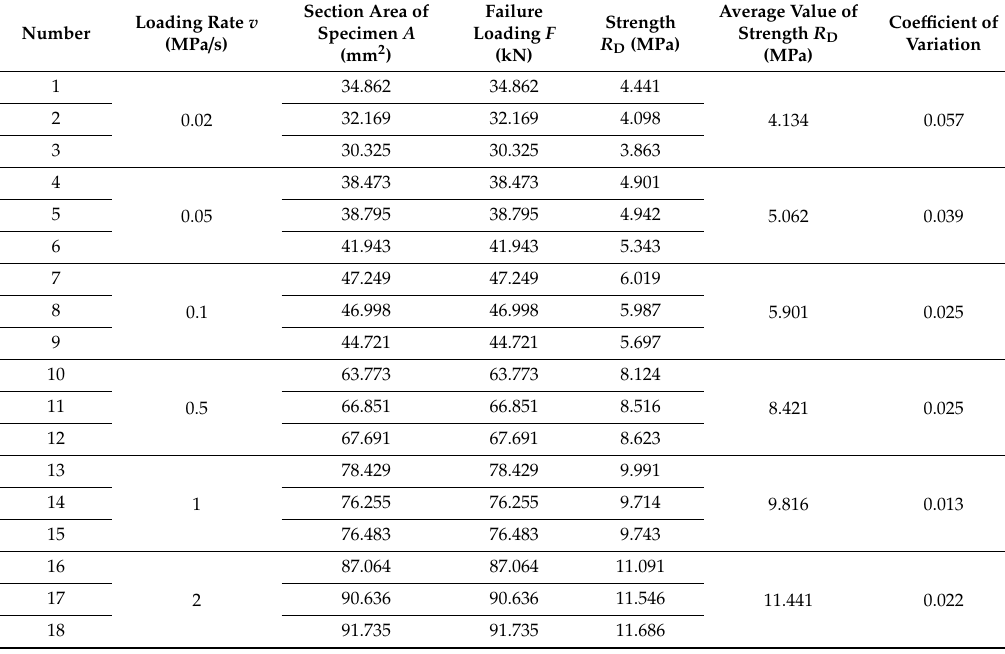
Table 7. Test results of unconfined compressive strength of asphalt mixture.